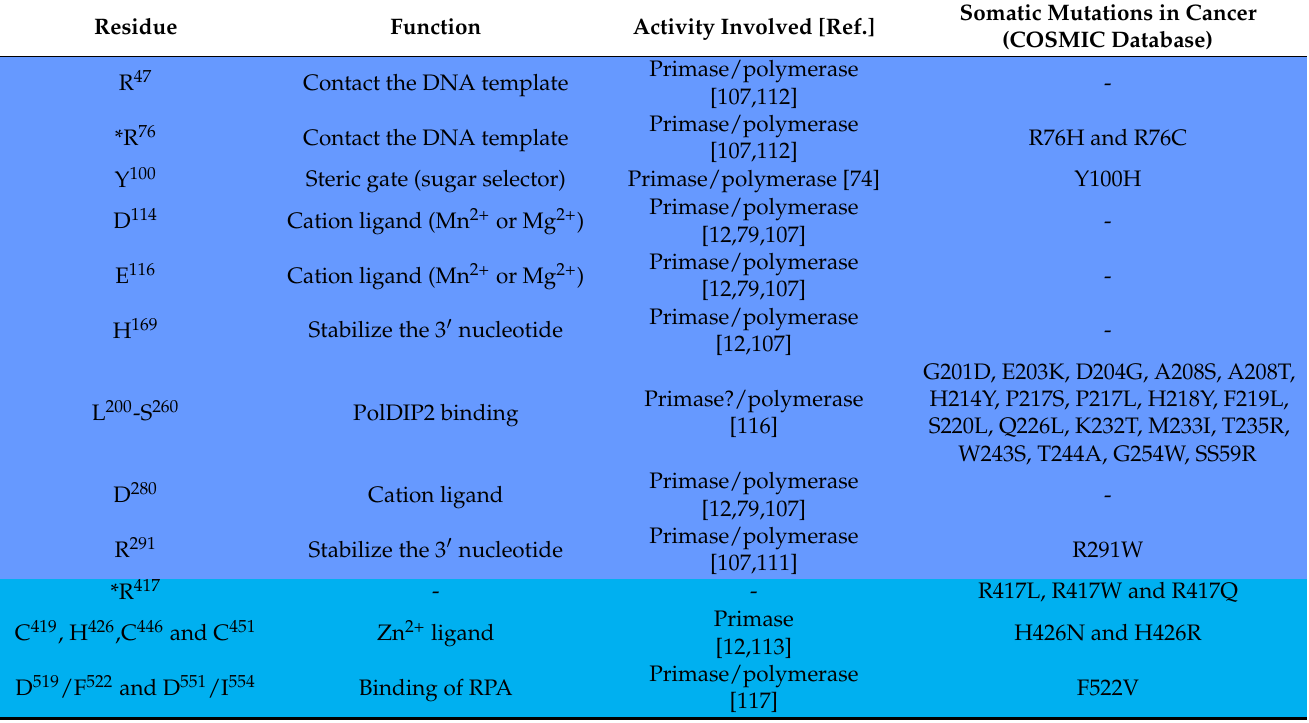
Table 1. Key residues of human PrimPol. Function, activity and cancer-related mutations compiled in COSMIC or GDC databases are indicated. Residues frequently mutated in cancer are indicated by an asterisk. The AEP domain is colored in blue and C-terminal region in light